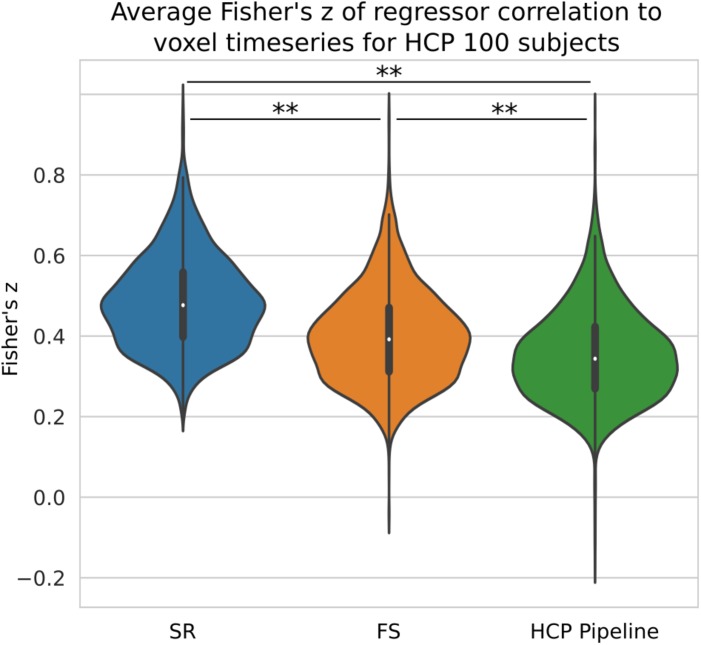
The Benefit of STC on short-TR data. Z-scores from voxels with the top 20 t-statistics for 100 HCP unrelated subjects. Violin plots show the combined z-scores of all 100 subjects from the 20 voxels with the highest t-values in the Shifted Regressor case when processed with the default volumetric HCP pipeline, with our proposed FS method, and with the Shifted Regressor. This shows the clear benefit of applying STC to short TR (0.72 s), multiband data.